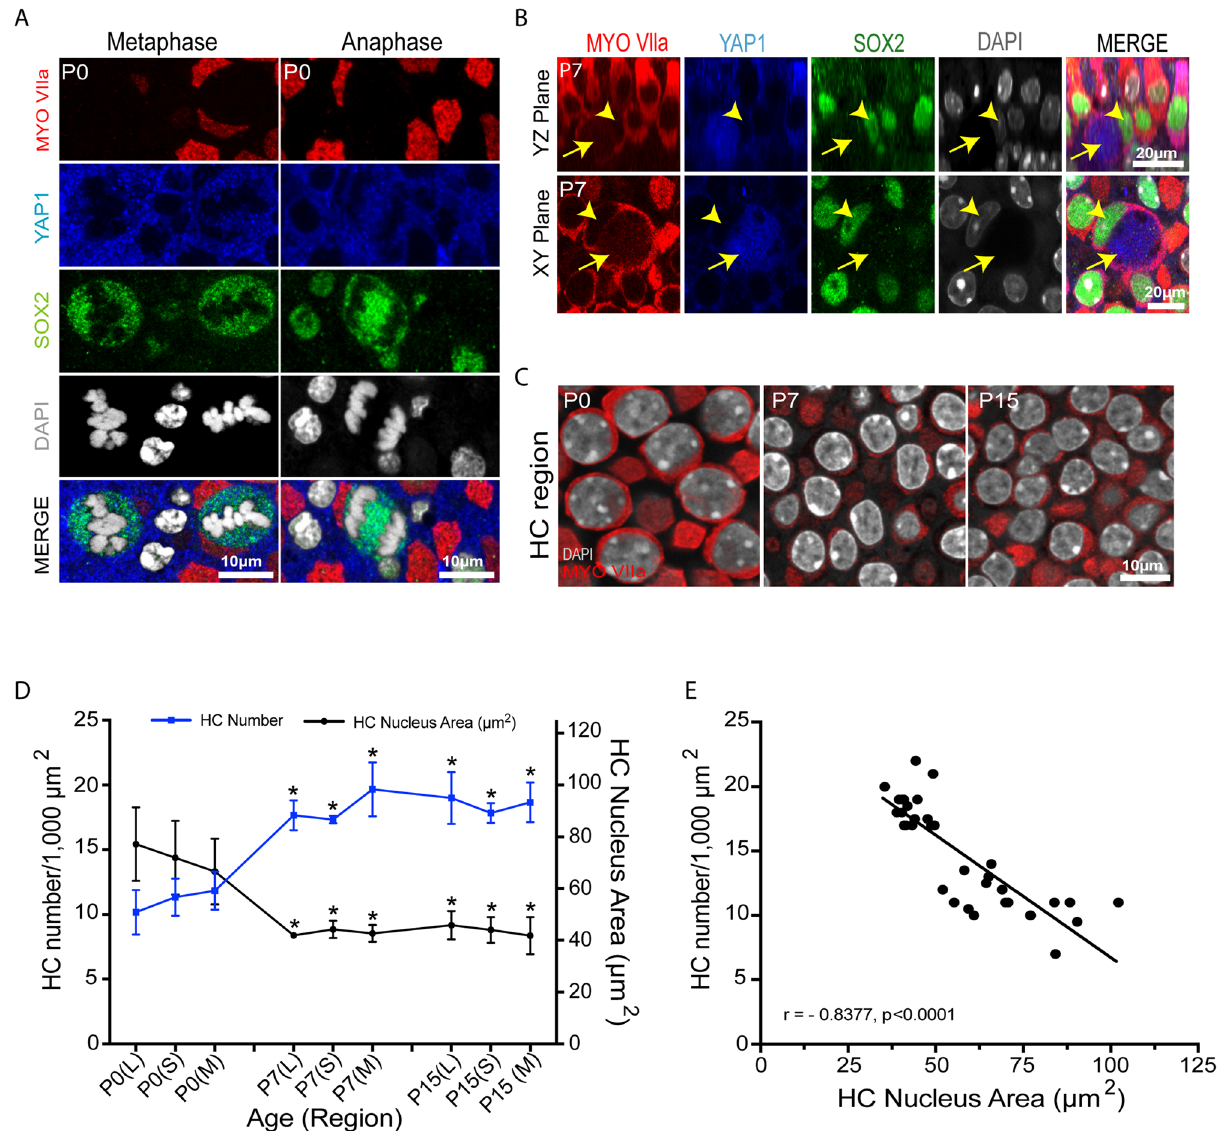
Figure 2. Mitotic cells, atypical hair cells and the decrease in hair cell nuclear area in the developing mouse utricle. ( A ) Confocal images of mitotically dividing cells showing metaphasic and anaphasic chromosome alignment in whole mount utricles at P0, with immunolabels for Myosin VIIa (red), YAP1 (blue), SOX2 (green) and DAPI (grey). Light granular labeling of YAP1 was observed in mitotically dividing SOX2-positive cells. ( B ) High levels of YAP1immunolabeling (blue) were observed in a small population of Myosin VIIa (red) and SOX2 (green) double-positive ‘atypical hair cells (yellow arrow; yellow arrowhead points at the SOX2 positive nucleus). Images were obtained at P7. ( C ) Confocal images from the developing mouse utricle, showing changes in the size of hair cell nuclei. Labels: Myosin VIIa (red), and DAPI (grey). ( D , E ) Quantitative data on utricle hair cell density and hair cell nuclear area during postnatal development. All data were obtained from 1000 µm 2 regions within the lateral extrastriolar, striolar and medial extrastriolar regions. ( D ) At P7 and P15, a significant increase in hair cell number and decrease in hair cell nucleus area was observed throughout the utricle, relative to P0 (p < 0.0001). ( E ) Significant negative Pearson correlation was observed between hair cell number and nuclear area in the developing mouse utricle (p < 0.0001). Data expressed as mean ± SD. Statistical test used two-way ANOVA followed by Bonferroni’s post hoc test (*p value < 0.05 relative to P0). N = 3–6